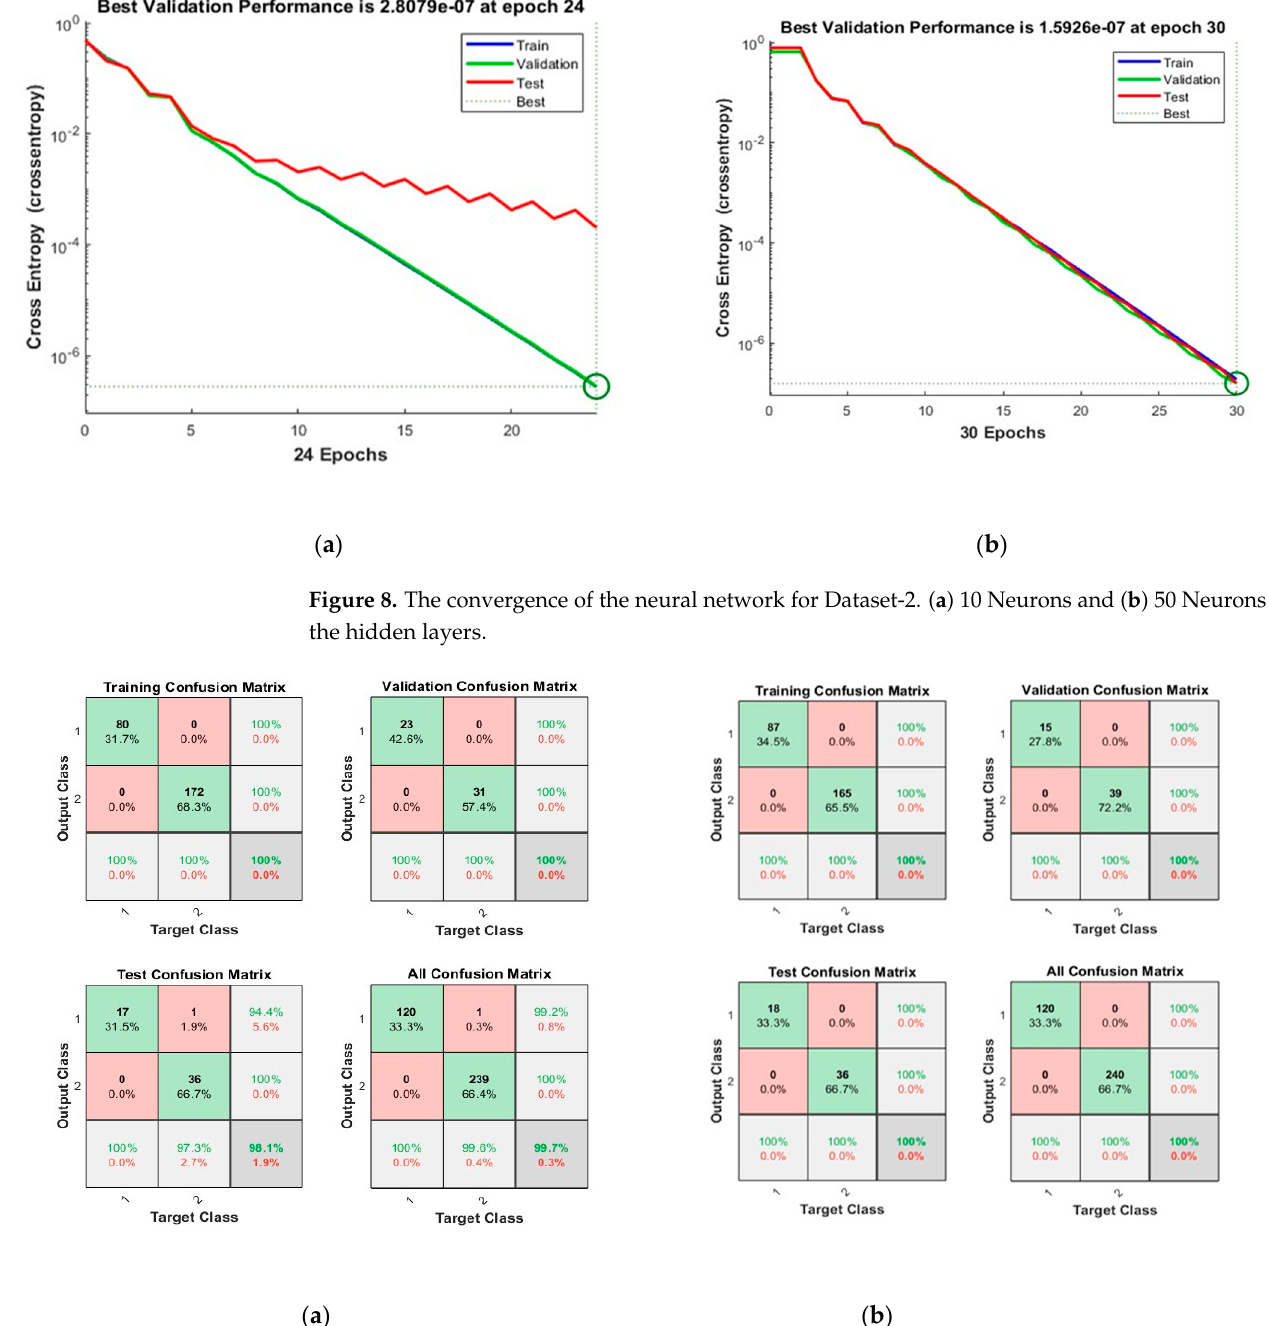
Figure 9. Confusion matrices of Dataset-2, where class label 1 shows the Normal operating conditions and class label 2 shows the Leak operating conditions of the pipeline using ( a ) 10 Neurons and ( b ) 50 Neurons.